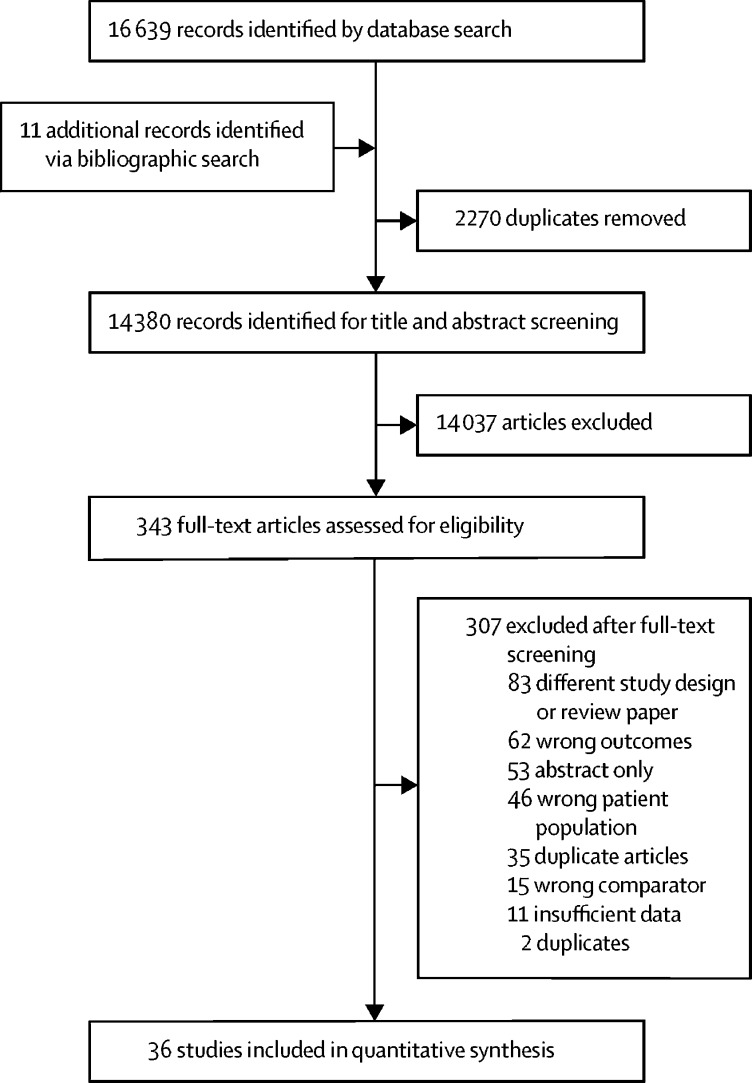
Study selection